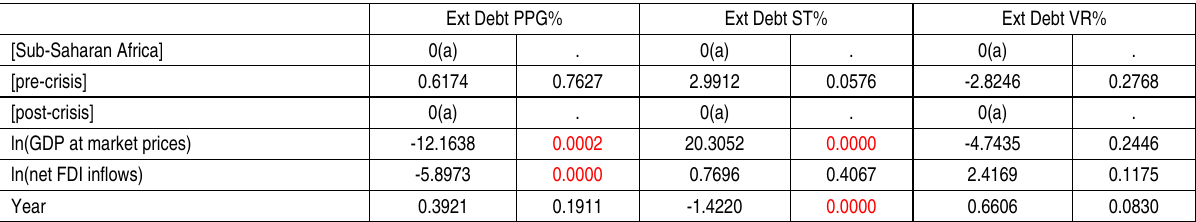
Table 11 (cont.). Fixed effects panel regression for PPG% external debt, ST% external debt,